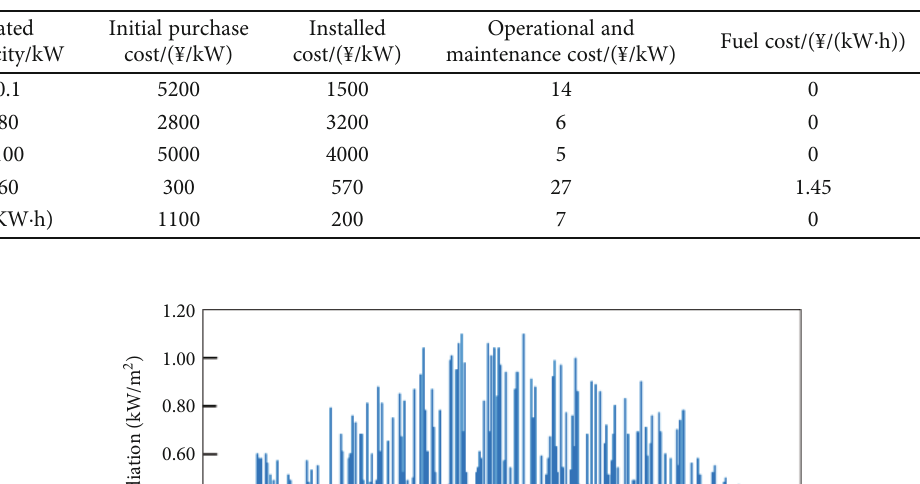
Table 2: The relevant parameters of distributed power sources.